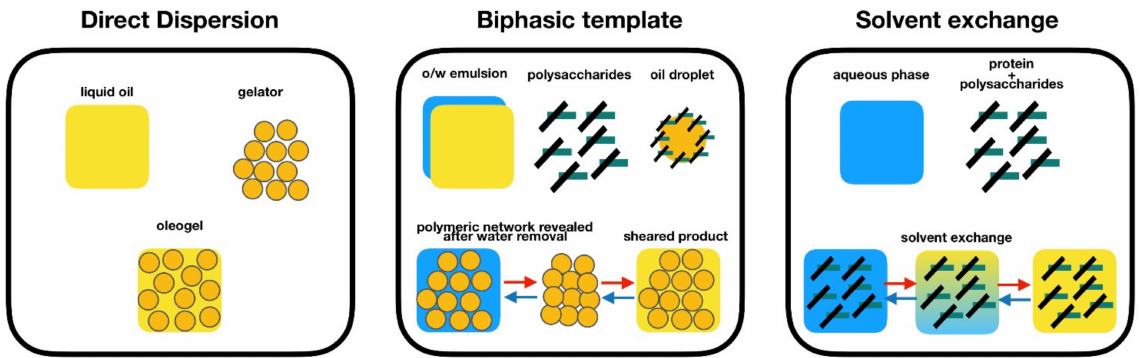
Figure 2. Strategies for the formation of oleogels. Reprinted by permission from Springer: